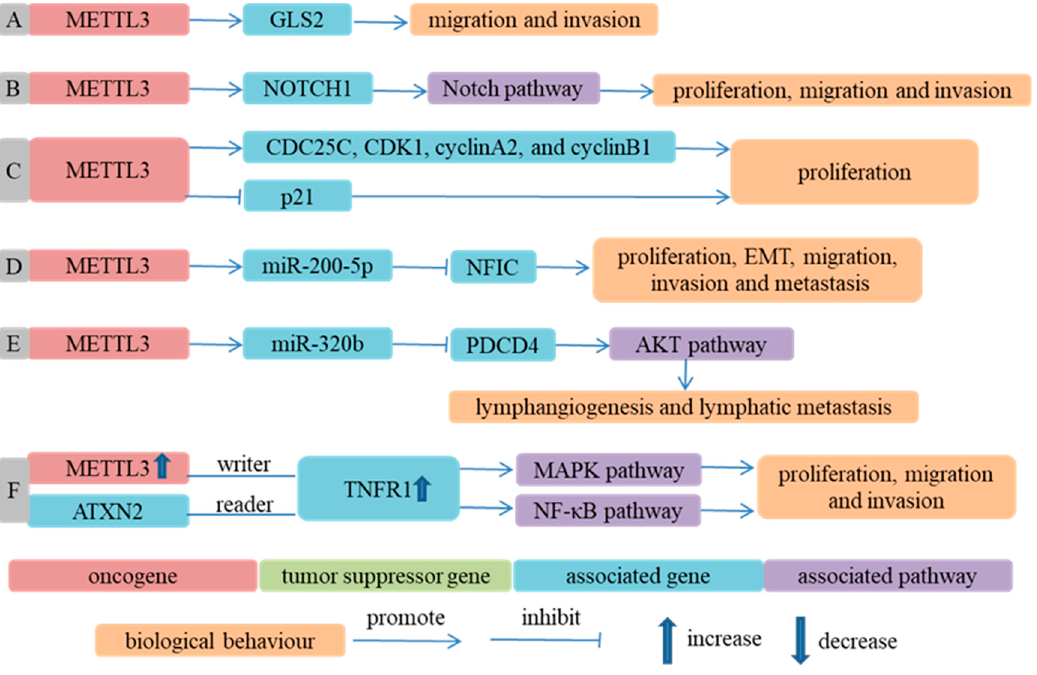
Figure 1. Methyltransferases participate in ESCA progression in an m 6 A-dependent way. ( A ) Ref. [59] METTL3 upregulated GLS2 expression through increasing m 6 A modification level of GLS2 and promoted migration and invasion of ESCC cells; ( B ) Ref. [60] METTL3 upregulated NOTCH1 expression through increasing m 6 A modification level of NOTCH1, activated Notch signaling pathway and thus promoted proliferation, migration and invasion of ESCC cells; ( C ) Ref. [85] Depletion of METTL3 significantly reduced m 6 A modification levels of ESCC cells. METTL3 promoted proliferation of ESCC cells by increasing CDC25C, CDK1, cyclin A2 and cyclin B1 amounts and reducing p21 amounts; ( D ) Ref. [75] METTL3 upregulated miR-200-5p expression through increasing m 6 A modification level of pri-miR-200-5p, inhibited expression of NFIC and promoted malignant biological behavior of ESCC cells; ( E ) Ref. [76] METTL3 elevated miR-320b expression through increasing m 6 A modification level of pri-miR-320b, inhibited expression of PDCD4 and then activated AKT signaling pathway, leading to lymphangiogenesis and lymphatic metastasis of ESCC cells; ( F ) Ref. [61] ATXN2 bound to TNFR1 methylated by METTL3 (upregulated in ESCC samples) and augmented translation of TNFR1. TNFR1 promoted malignant behavior of ESCC cells, such as